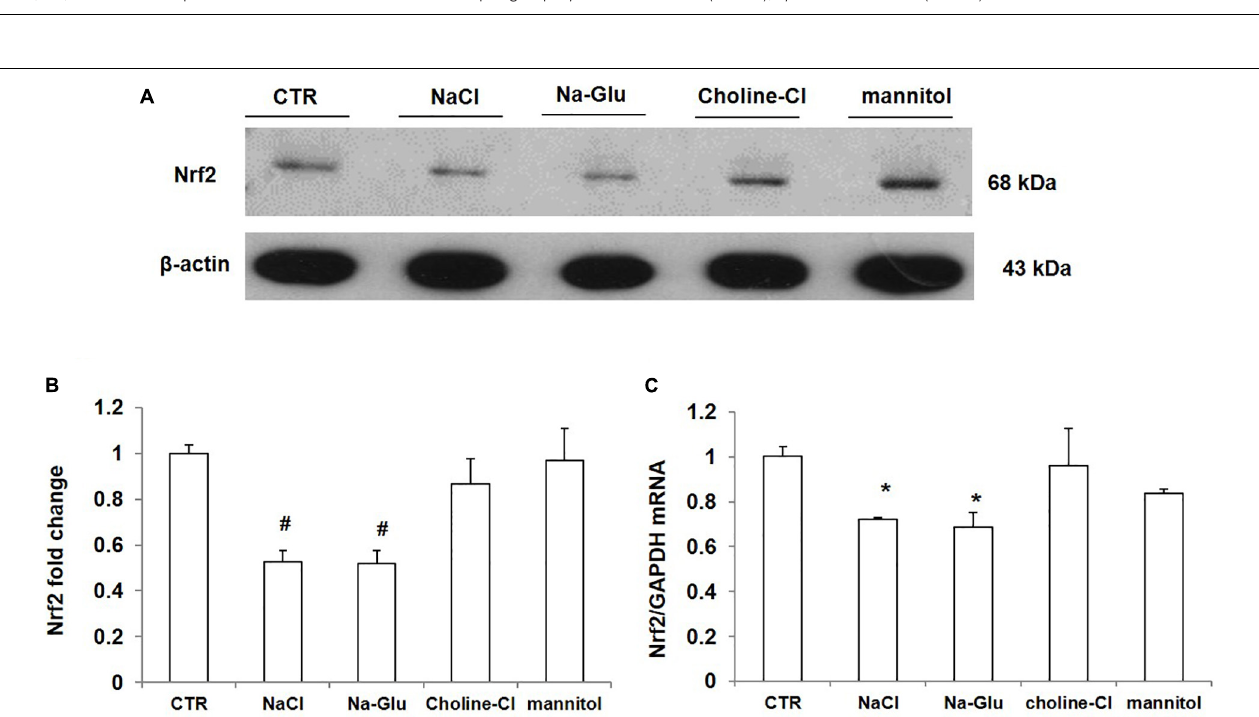
FIGURE 6 | The protein and mRNA expression of Nrf2 in mpkCCD cells after the treatments of NaCl, Na-Glu, choline-Cl, and mannitol. (A) Western blotting analysis of Nrf2 and β -actin. (B) Densitometric analysis of Nrf2 normalized by β -actin. (C) qRT-PCR analysis of Nrf2in mpkCCD cells. The presented data are means ± SE. n = 3 per group. ∗ p < 0.05 vs. CTR (control); # p < 0.01 vs. CTR (control).